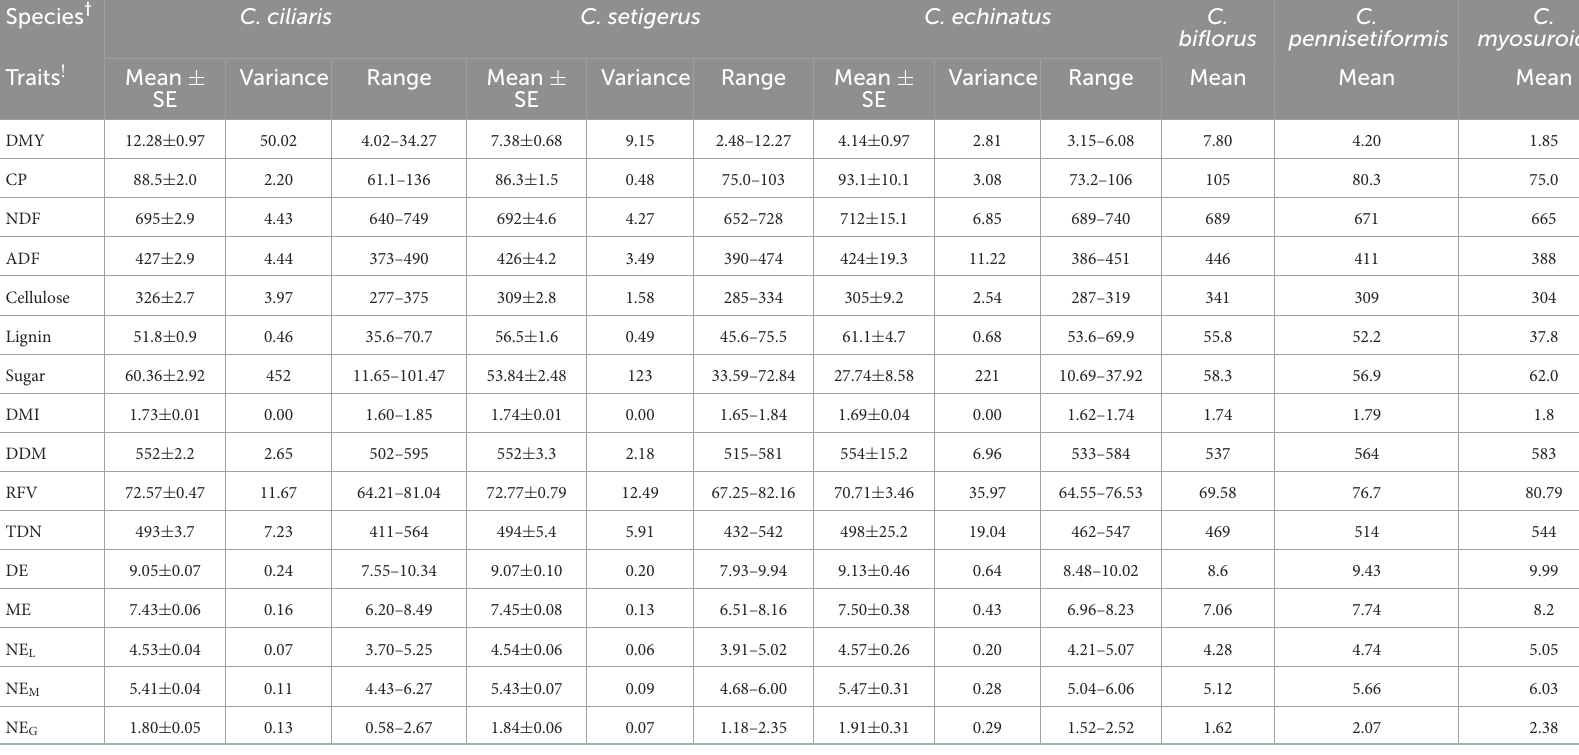
TABLE 1 Mean performance of Cenchrus species for chemical components and nutritional quality